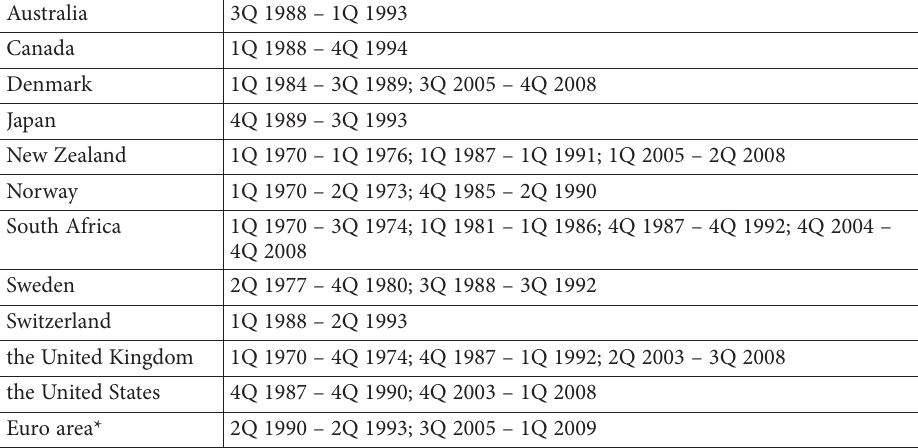
Table 2. House price booms (1970–2016) (source: own